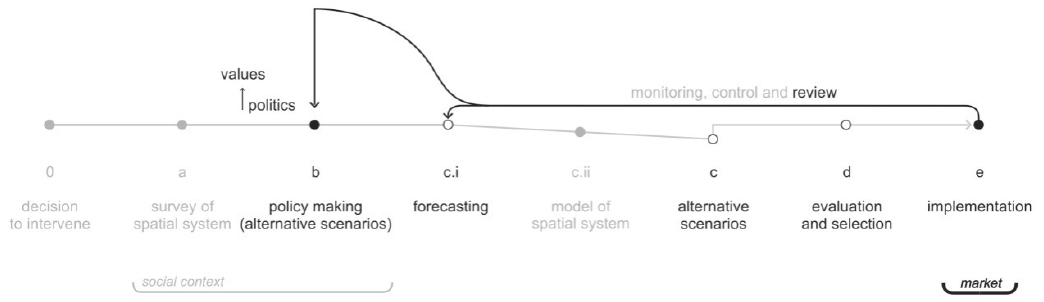
Figure 5. The elements of incremental economic planning, according to Lindblom [14], in diagrammatic form, with the comprehensive model’s components in the background. White circle: coincidence with McLoughlin’s component. Gray circle: lack of the corresponding McLoughlin component. Dark circle: the central component, also included in McLoughlin’s components. Below the axis: contextual factors.